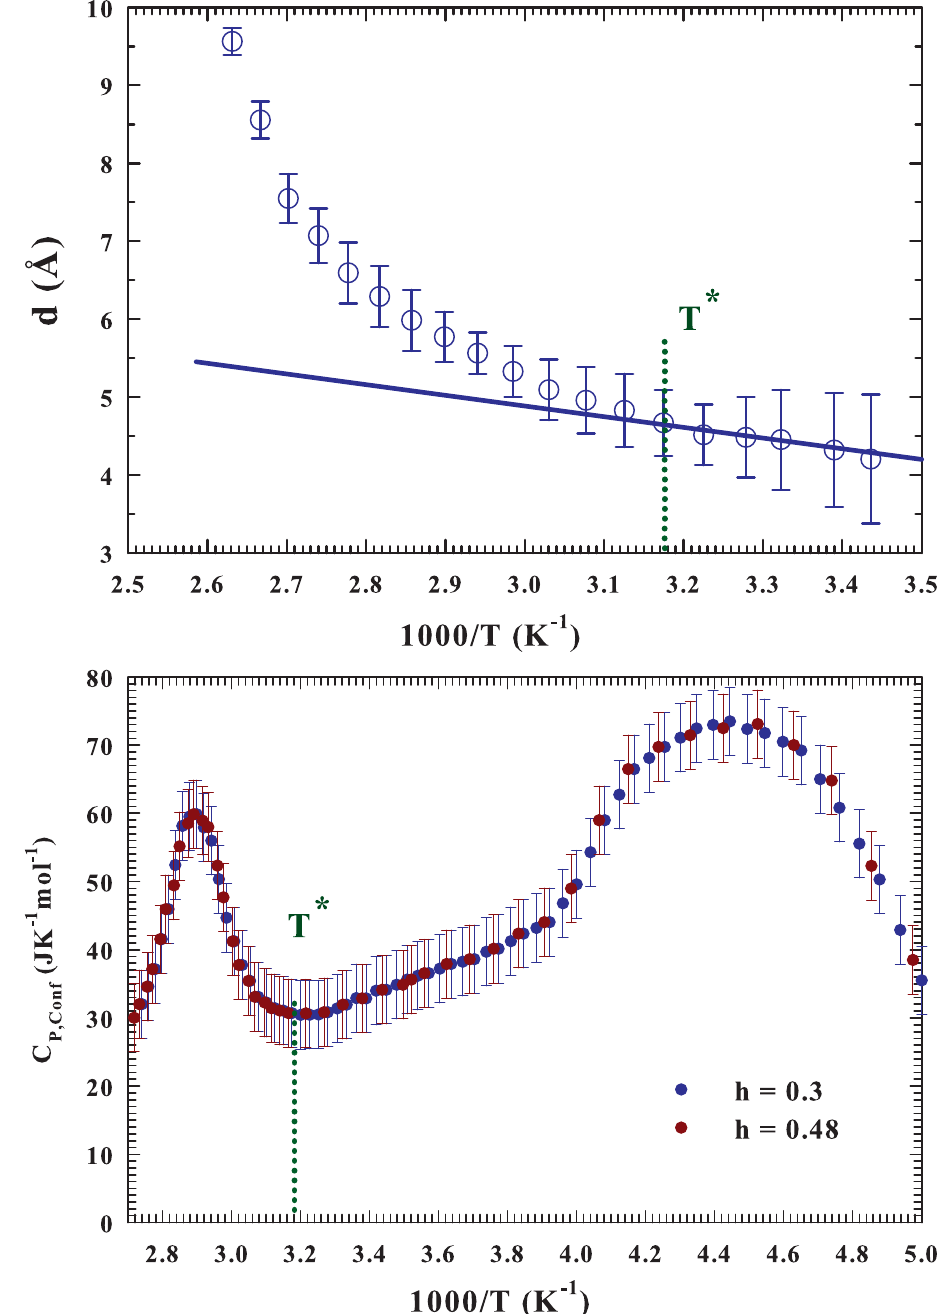
Figure 3. The upper panel illustrates in an Arrhenius plot the temperature evolution of the molecular migration distance d , calculated from neutron scattering data measured in the interval 290–380 K [35]. Whereas the bottom one proposes, in a similar plot, the configurational specific heat. C P , conf evaluated according to the Adam-Gibbs model [47] (range 200 < T < 370 K) from the lysozyme hydration water self-diffusion D S